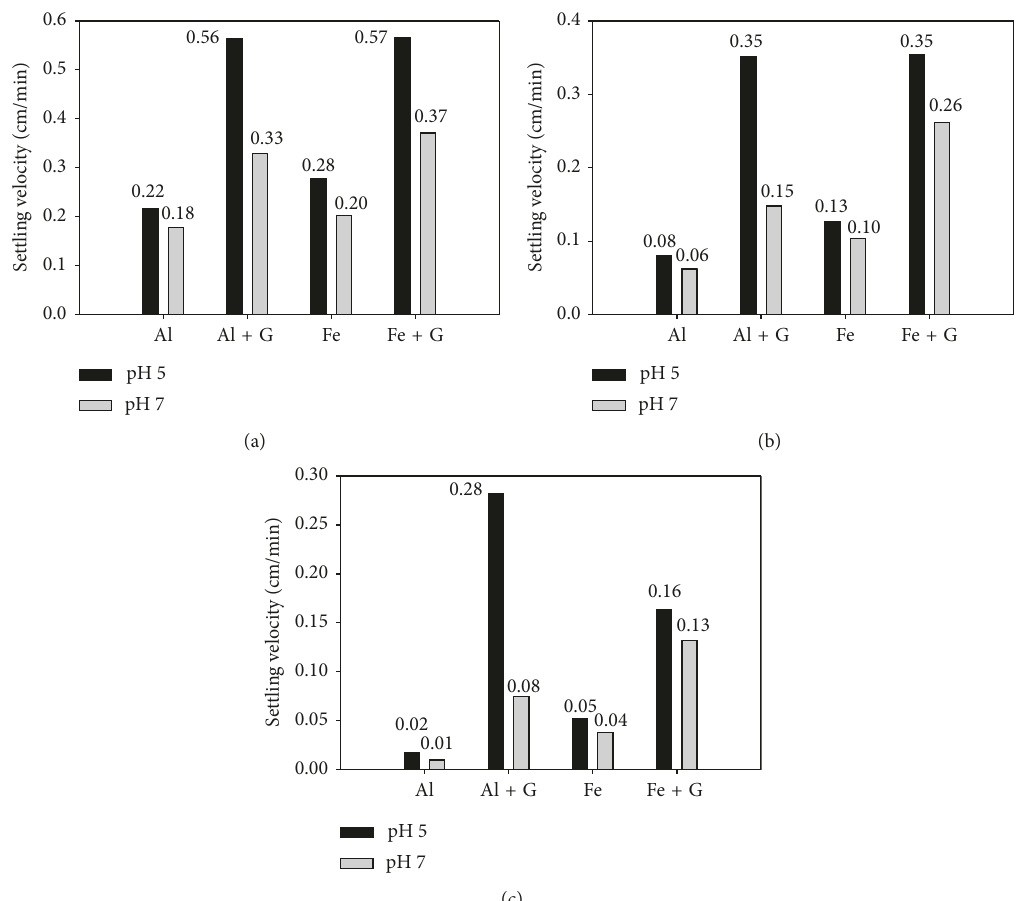
Figure 8: Settling velocity of laterite suspension at different experimental conditions: a (10g/L); b (20 g/L); c (30g/L); Al (alum); Fe (FeCl Al +G (alum+ 25mg/L Grewia spp. biopolymer); Fe+G (FeCl 3 +25mg/L Grewia spp. biopolymer).